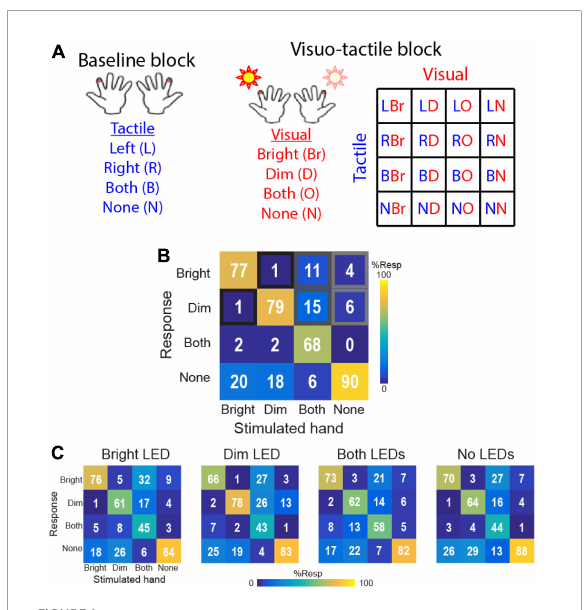
FIGURE1 Task and results from Wani et al. (2021). (A) 4AFC tactile localization task conditions in baseline block (tactile only) and visuo-tactile block comprising parametric combination of bright and dim LED flashes paired with touch on the left or right hands. Subjects performed the tactile 4AFC task while ignoring the visual cues. (B) Baseline block performance. Confusion matrices show group-averaged ( n = 16) response probabilities on trials comprising tactile stimulation to the hand associated with the bright LED, the hand associated with the dim LED, both hands simultaneously, or no tactile stimulation. (C) Visuo-tactile block performance. Group-averaged response probabilities on the 4AFC tactile localization task in the context of bright LED illumination, dim LED illumination, illumination of both LEDs, and no visual